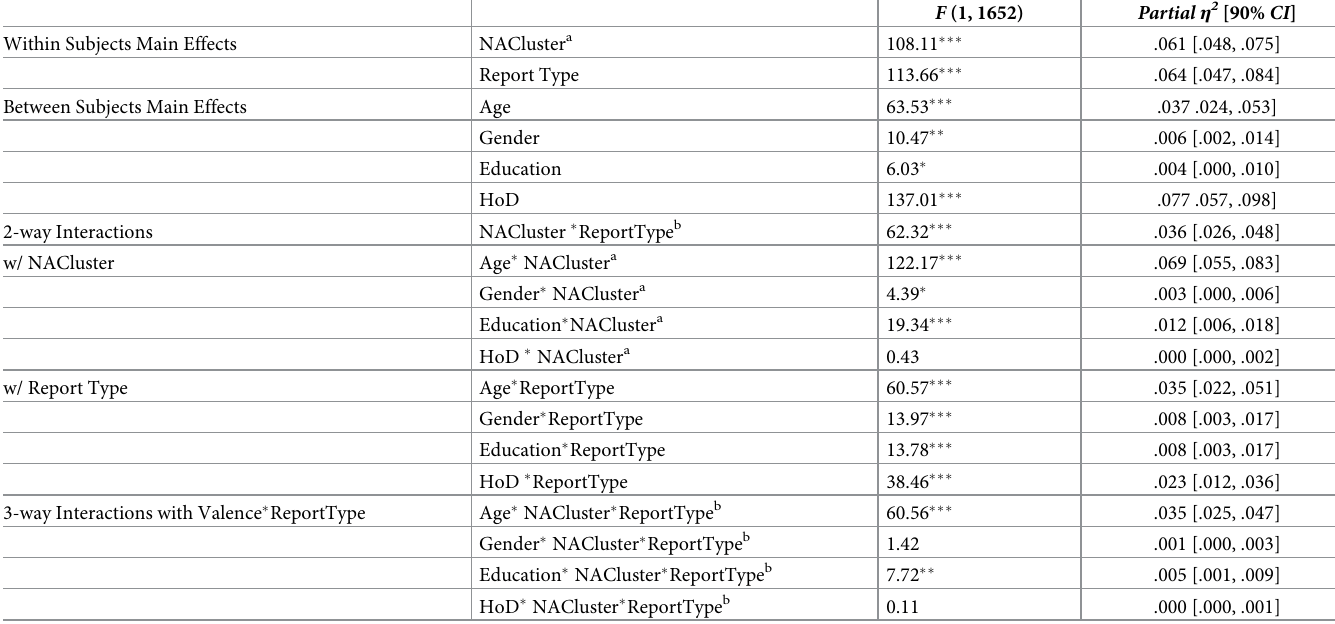
Table 3. Effects of history of depression on experience and recall of sadness, anxiety, &